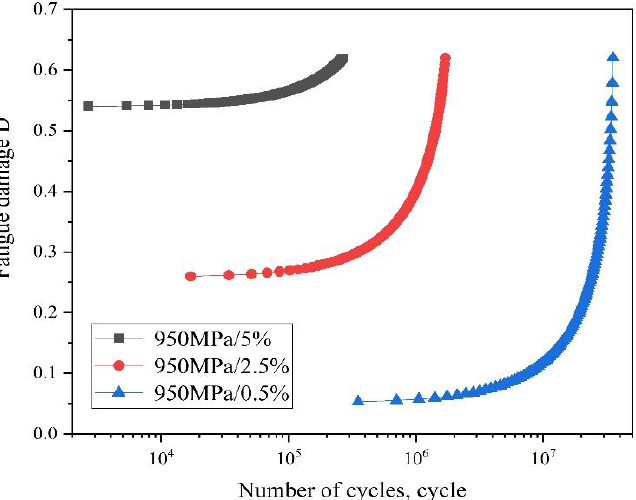
Figure 9. Prediction of fatigue damage evolution for different LCF predamage specimens at 450 MPa stress amplitude.